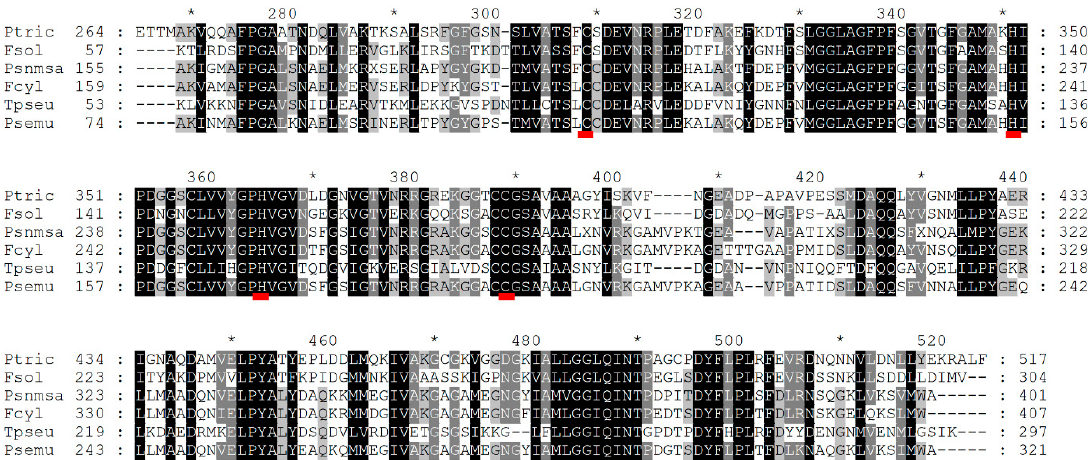
Figure 2. Alignment of the θ -CA from different diatom species. Only partial sequences are shown. Black, dark gray, and light gray indicate 80% or above, 70%, and 60% of amino acid identity, respectively. Species and protein IDs are the following: Ptric, Phaeodactylum tricornutum (protein ID: XP_002177507.1 – NCBI; 517 aa); Fsol, Fistulifera solaris (protein ID: GAX24004.1 – NCBI; 304 aa); Psnma, Pseudo-nitzchia multistriata (protein ID: VEU35824.1 – NCBI; 401); Fcyl, Fragilariopsis cylindrus (protein ID: OEU22620.1 – NCBI; 407 aa); Tpseu, Thalassiosira pseudonana (protein ID: XP_002297283.1 – NCBI; 297 aa); Psemu, Pseudo-nitzchia multiseries (protein ID: 239261 – JGI; 321 aa). The amino acids underlined in red are possibly involved in the active site, as shown by Kikutani et al. [11] Alignments were performed with ClustalW, using MEGAX software, and the figure was processed with GeneDoc.